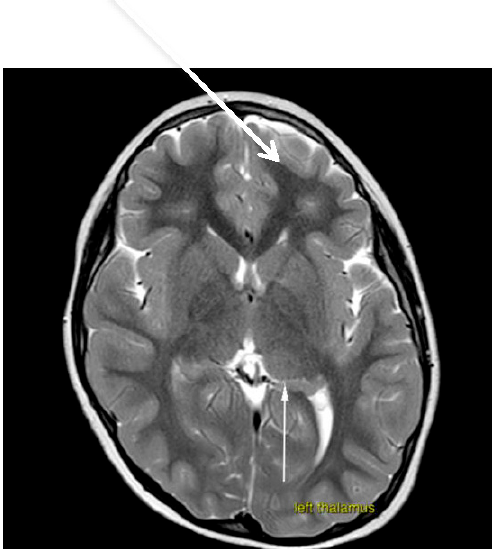
Figure 3. MRI brain imaging shows that the volume of the left thalamus is larger than the right.